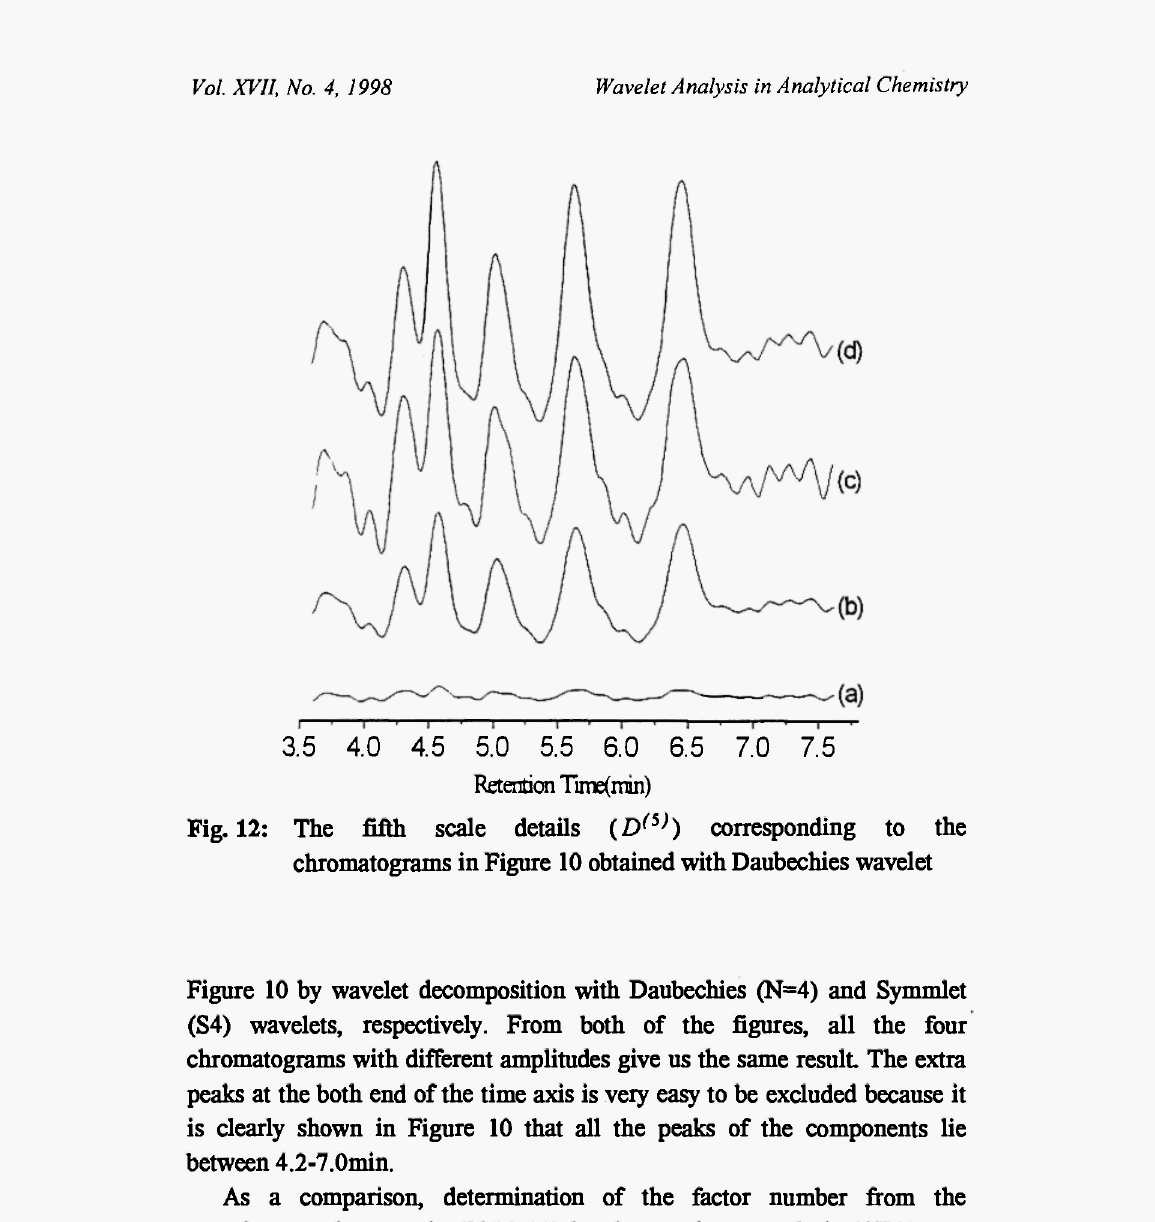
Fig. 12: The fifth scale details (D (5) ) corresponding to the chromatograxns in Figure 10 obtained with Daubechies wavelet